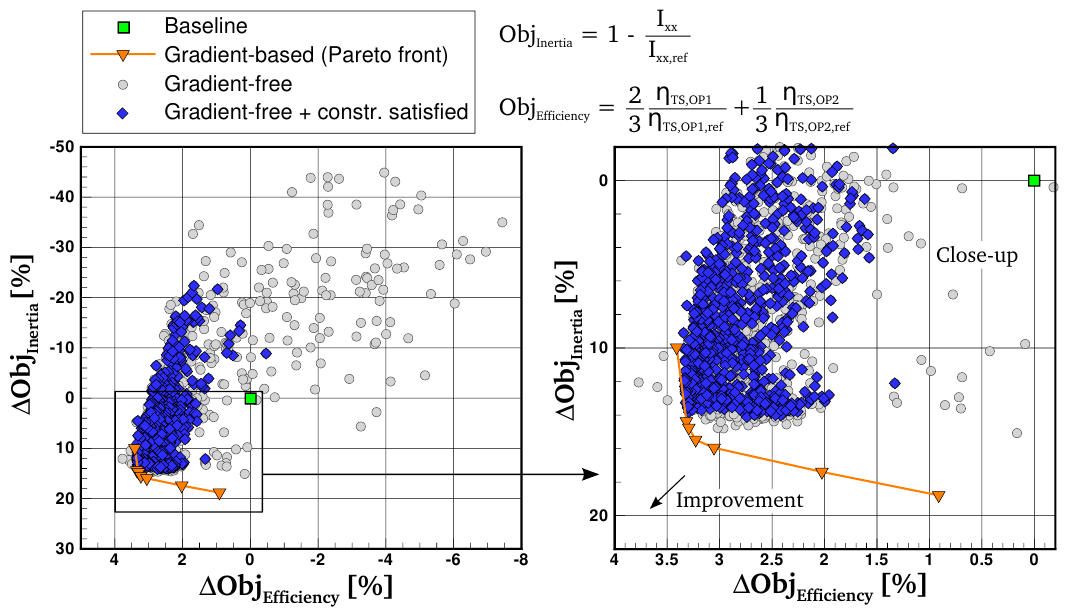
Figure 9. Objective space after 80 generations of the moment of inertia and total-to-static efficiency ( left ) with a close-up on the Pareto front ( right